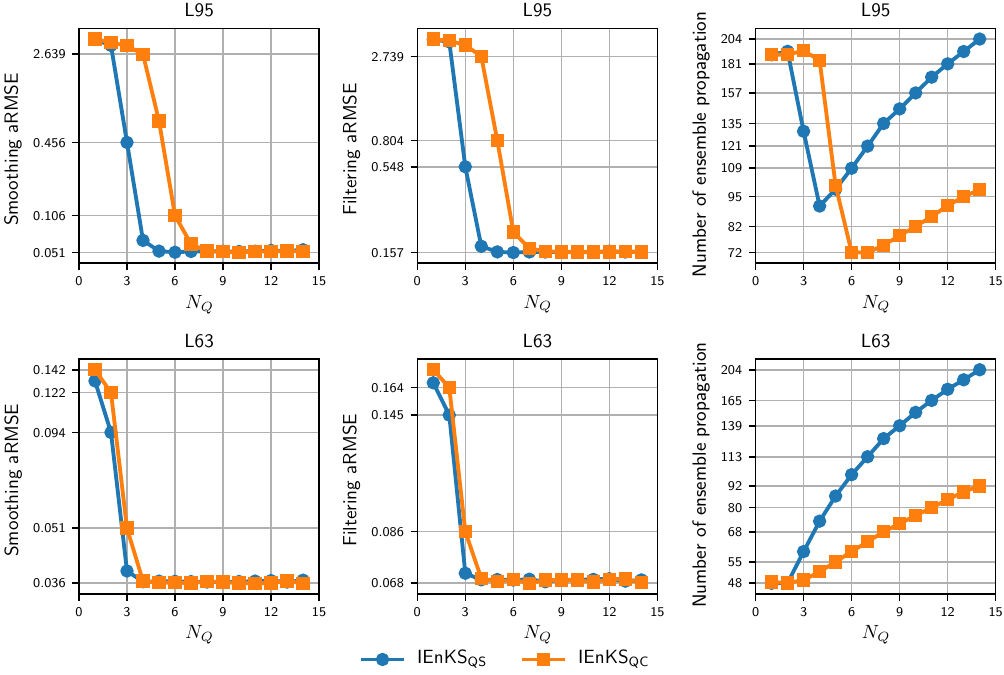
Figure 11. IEnKS QS and IEnKS QC ( S = L = 50) filtering and smoothing aRMSEs and number of ensemble propagations as a function of N Q for the L95 and L63 models (logarithmic scale). The ensemble propagations are in units of (cid:49)t